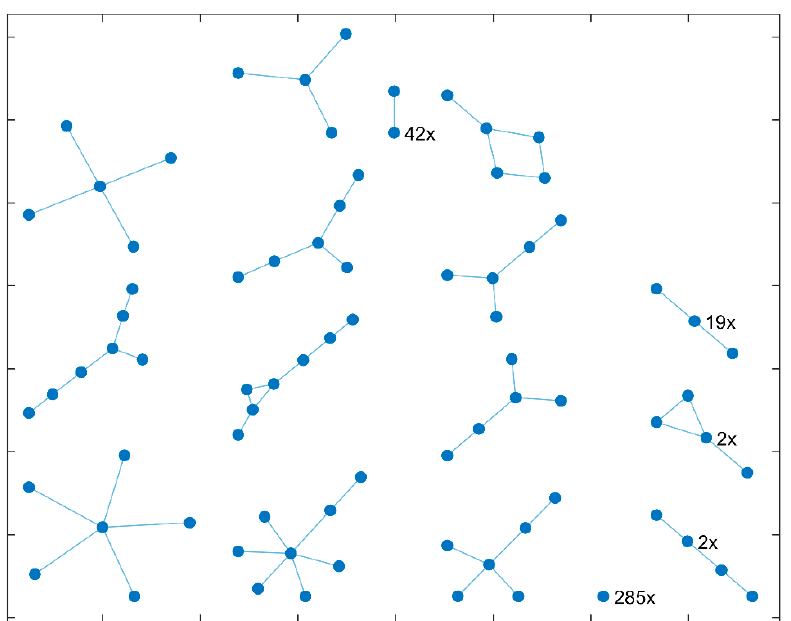
Figure 5. Visual interpretation of the split and merger links between clouds. Dots represent individual clouds (i.e., CloudIDs ) and lines represent splits or mergers of clouds. The labels indicate the number of times that the combination represented occurs in the data. As an example, the two dots, connected by a line, labeled ’42 ×’ indicates that there are 42 instances of a cloud originating from a split with another cloud or culminating in a merger.